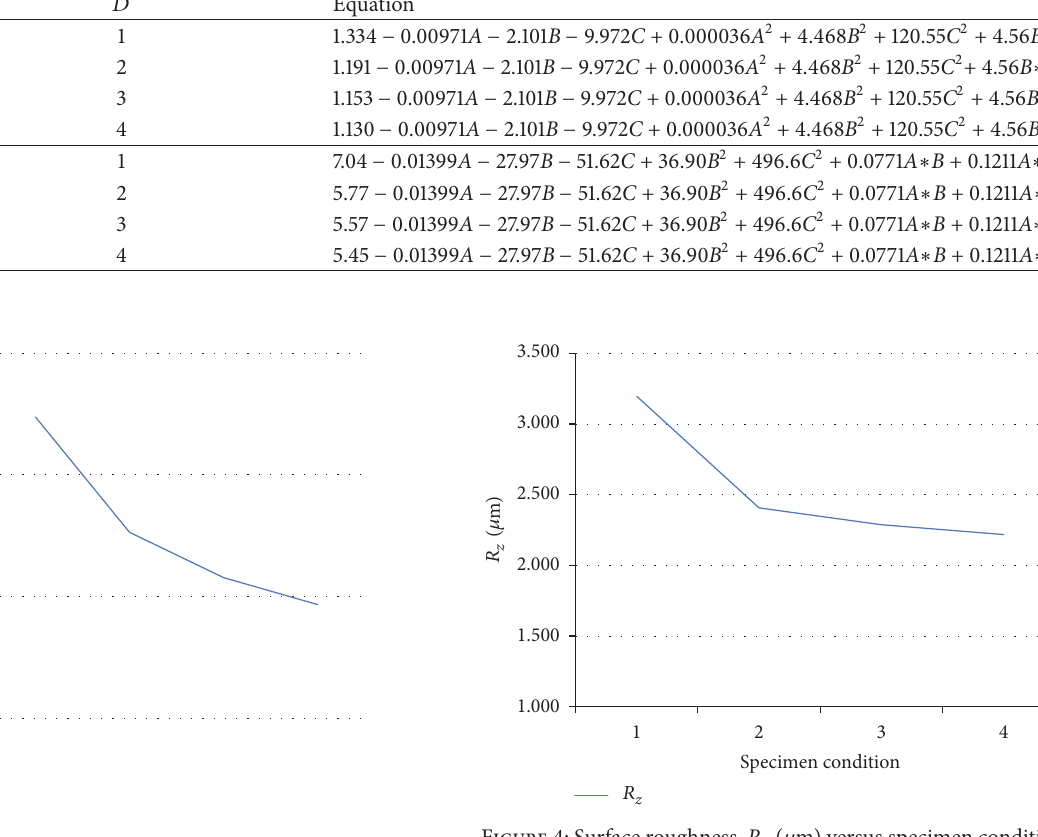
Figure 4: Surface roughness, 𝑅 𝑧 ( 𝜇 m) versus specimen